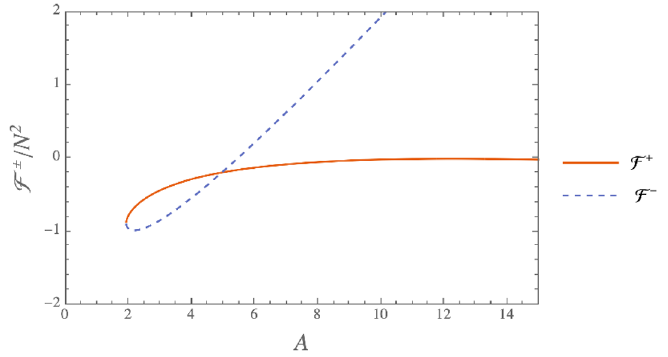
Figure 3. Two branches for τ = − 0 . 5 in the weak coupling phase. The smallest free energy dominates in the partition function. In the large N limit the first derivative with respect to A of the full partition function Z is discontinuous at A ∗ ≈ 4 . 948 .